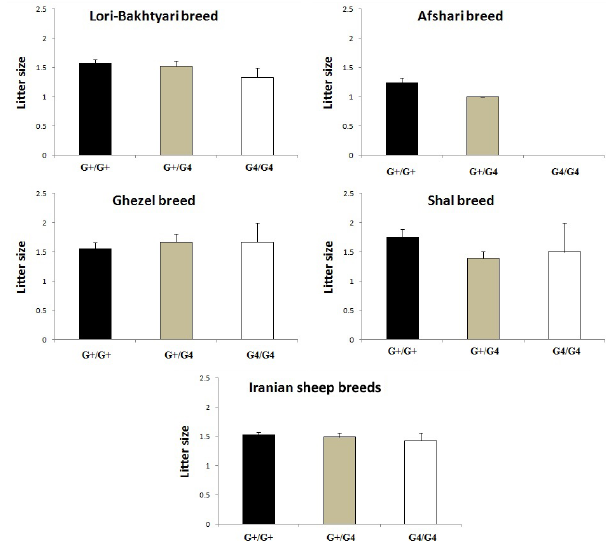
Figure 3. Litter size of Iranian ewes carrying the G1 mutation in the GDF9 gene.